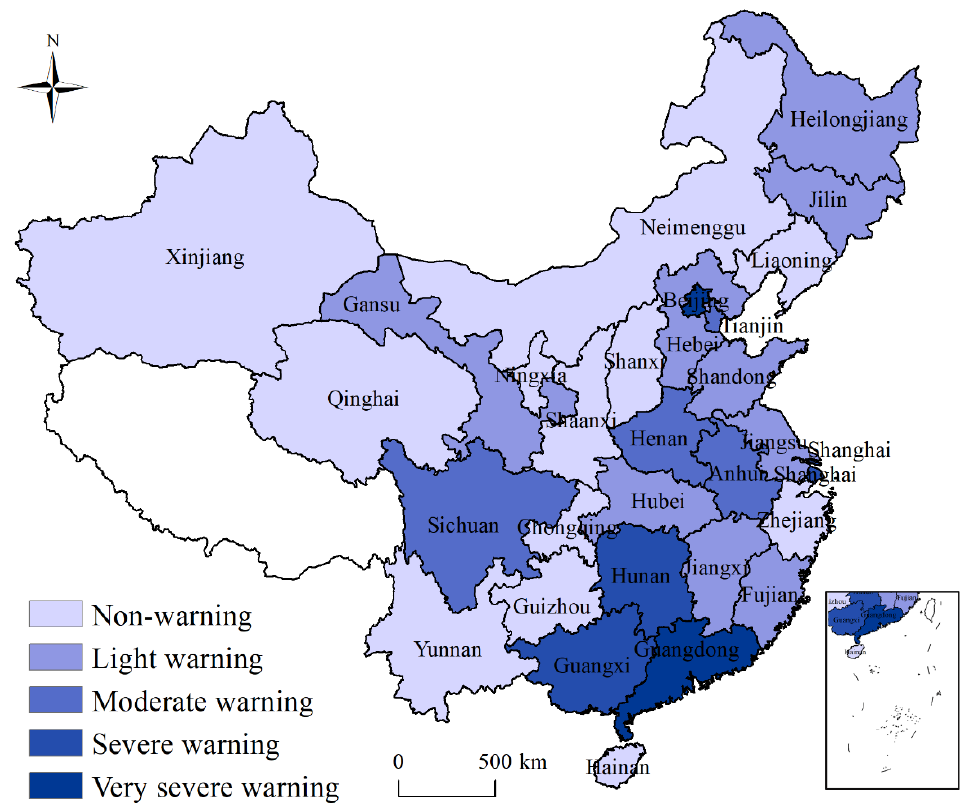
Figure 10. Early warning and dynamic changes of land finance risk.